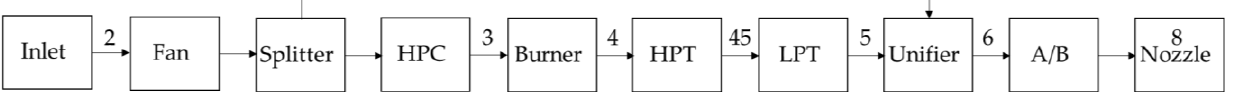
Figure 3. Engine process model diagram.